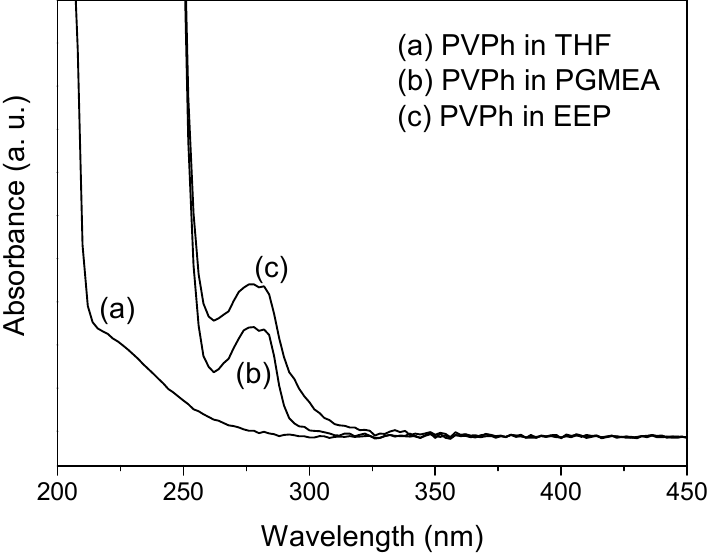
Figure 5. UV-visible absorption spectra of PVPh in various organic solvents: ( a ) tetrahydrofuran (THF), ( b ) propylene glycol methyl ether acetate (PGMEA), and ( c ) ethyl-3-ethoxypropionate (EEP).